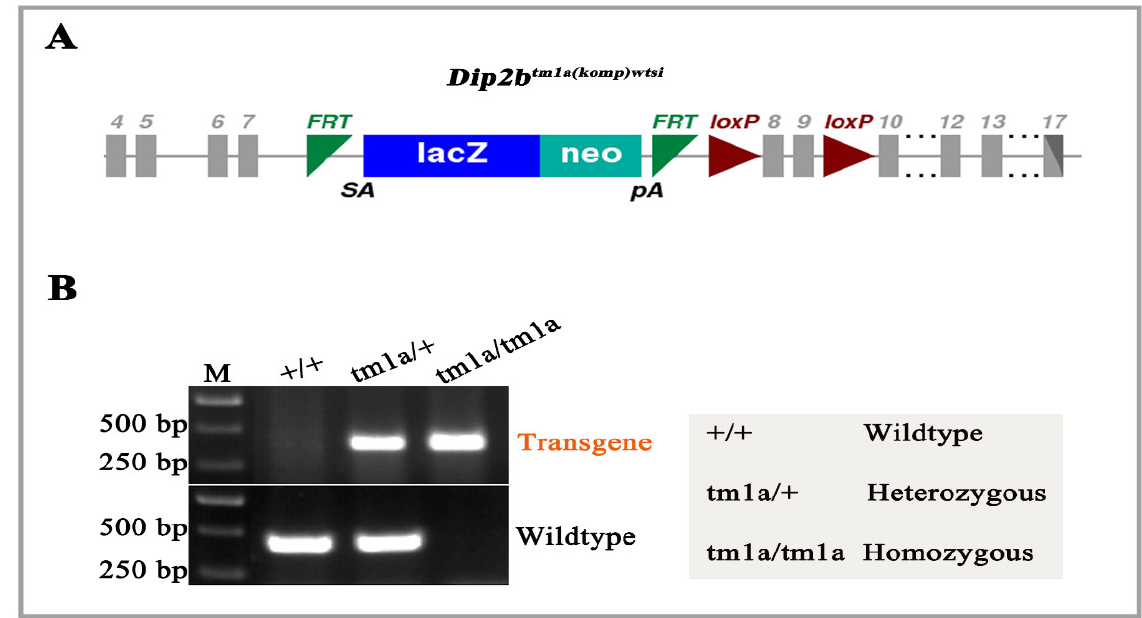
Figure 1. Tm1a knockout-first reporter tagged insertion allele and genotyping. ( A ) Structure of Dip2b tm1a (KOMP) Wtsi allele . A critical exon is flanked by loxP sites, with FRT, lacZ, neo, and FRT elements upstream of the critical exon. ( B ) Genotyping PCR results for tail biopsy from Dip2b tm1a/ + intercrossing mice. A 300 bp band appeared on the gel for the transgene allele and a 350 bp band for the wild-type allele.